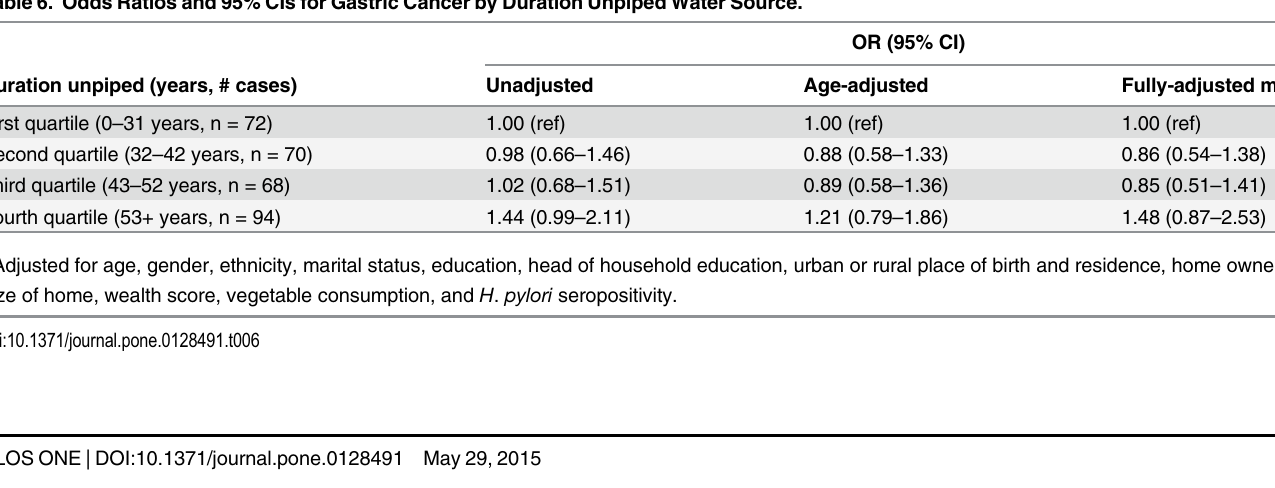
Table 6. Odds Ratios and 95% CIs for Gastric Cancer by Duration Unpiped Water Source.